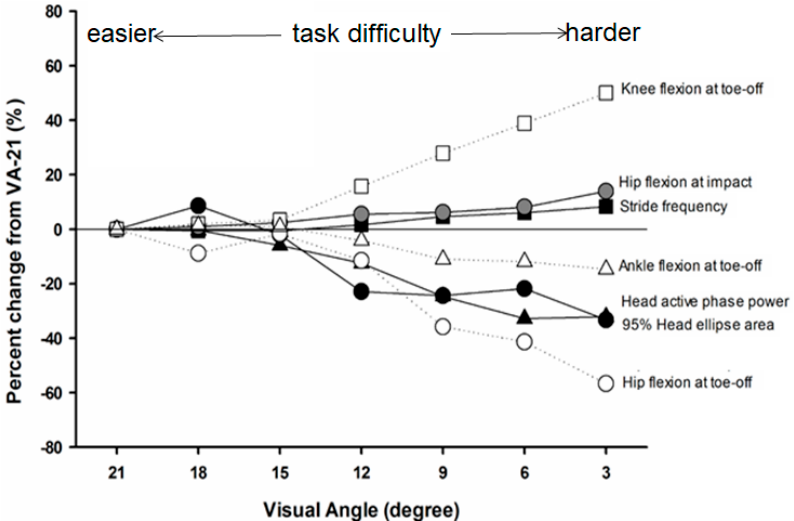
Figure 6. Mean percent changes for key dependent measures showing the significant e ff ect of visual condition from VA-21. Positive numbers indicate increased value in percentage from VA-21, and vice versa (adapted from Lim et al.